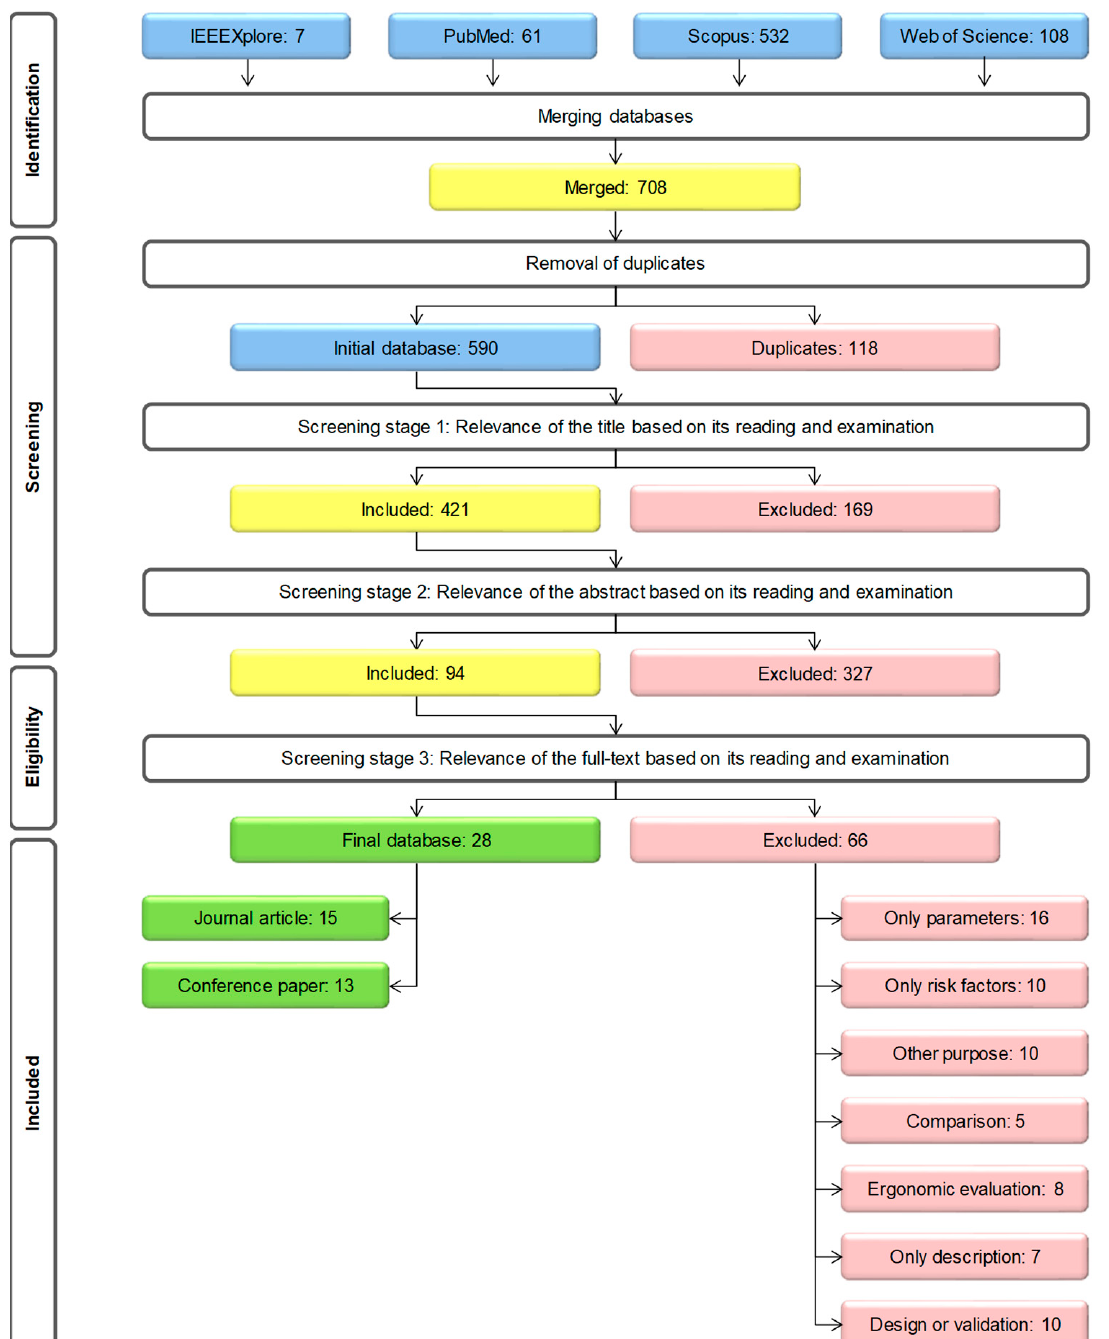
Figure 1. Summary review flow diagram.